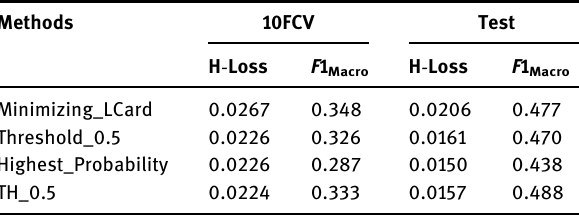
Table 3: Performance comparison of threshold calibration algorithms